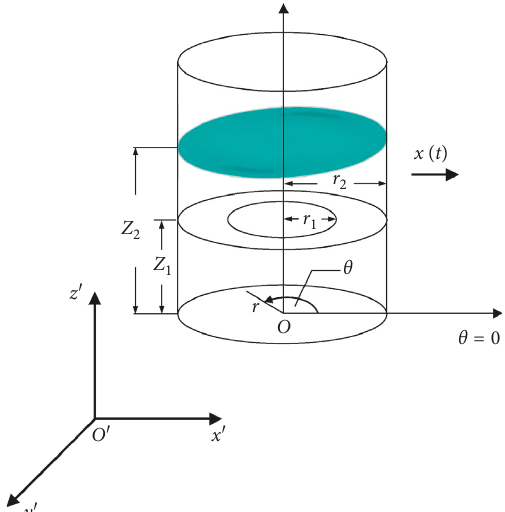
Figure 1: The partially liquid-filled rigid cylindrical container with an annular rigid baffle subjected to the lateral